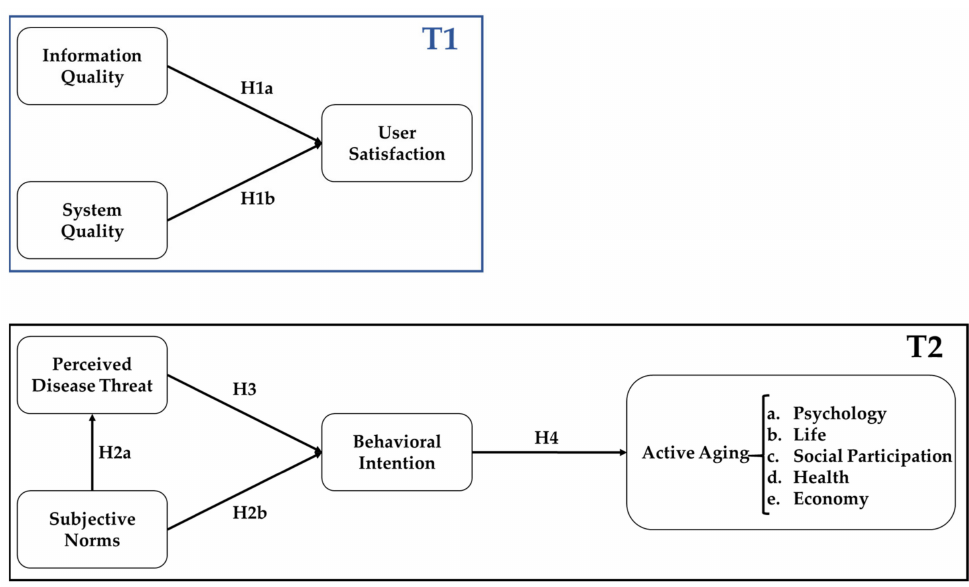
Figure 1. Research